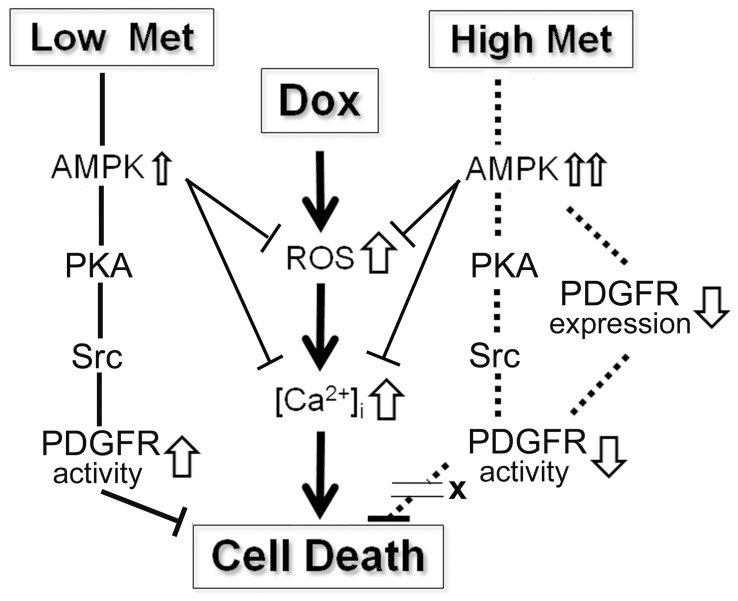
A hypothetical pathway for Met-mediated protection against Dox-induced toxicity in cardiomyocytes.Low dose (0.1 mM) Met induces moderate AMPK activation which is followed by sequential activations of PKA, Src and PDGFR and results in protection of the cells from Dox toxicity. High dose (1.0 mM) Met also leads to the sequential activations of AMPK, PKA and Src. With both dosages of the Met treatment, Dox induced ROS generations and [Ca2+]i levels are suppressed. However, the excessive activities of AMPK with the high dose Met causes a suppression of PDGFR expression in cardiomyocytes and the protective effect of low dose Met is abrogated.